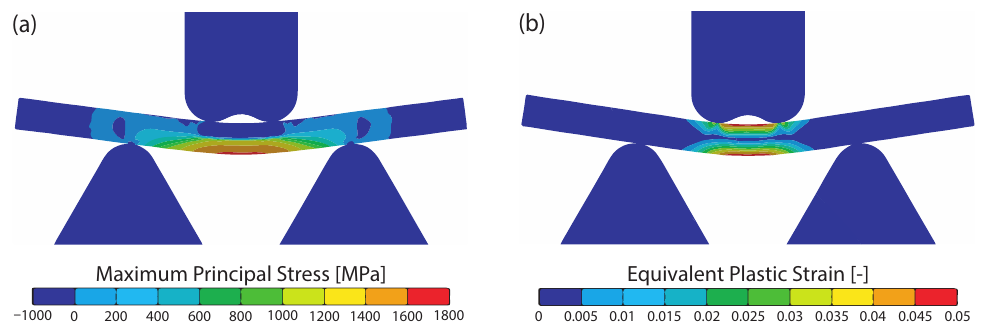
Figure 6. Finite element simulation of the bending test in the hardened state. The same material parameters have been used for the weld seam and the base material, ( a ) Maximum Principal Stress, ( b ) Equivalent Plastic Strain.